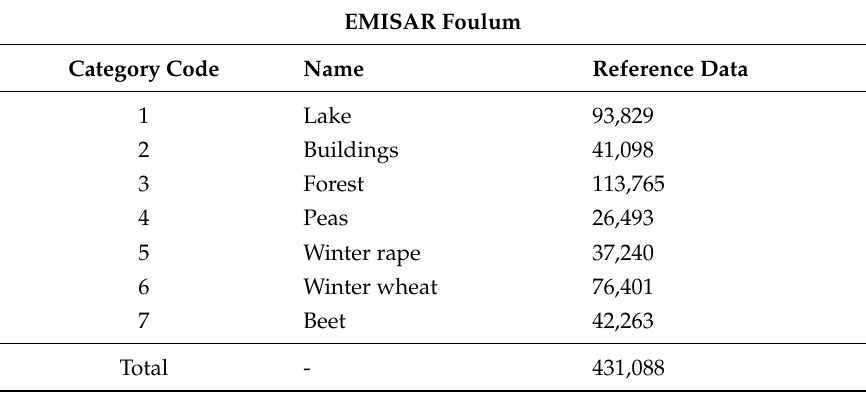
Table 3. Number of pixels in each category for the EMISAR